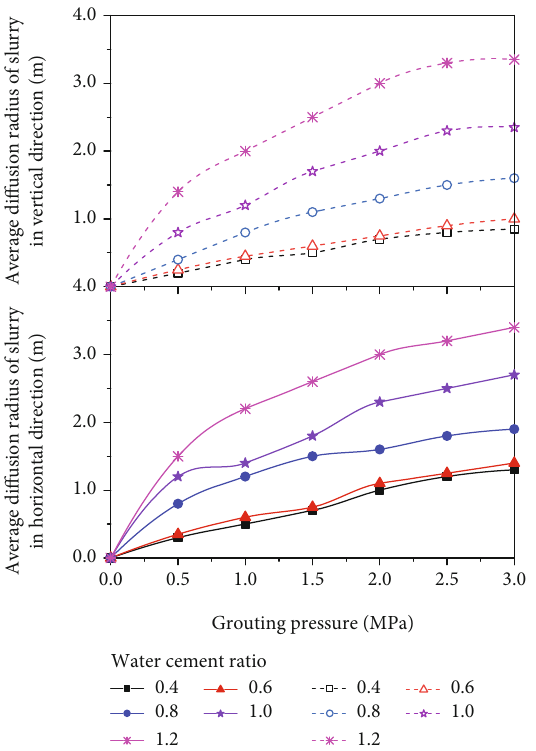
Figure 4: Variation law of slurry di ff usion range.